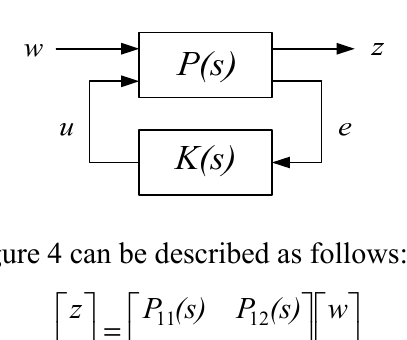
Figure 4. Standard form of H ∞